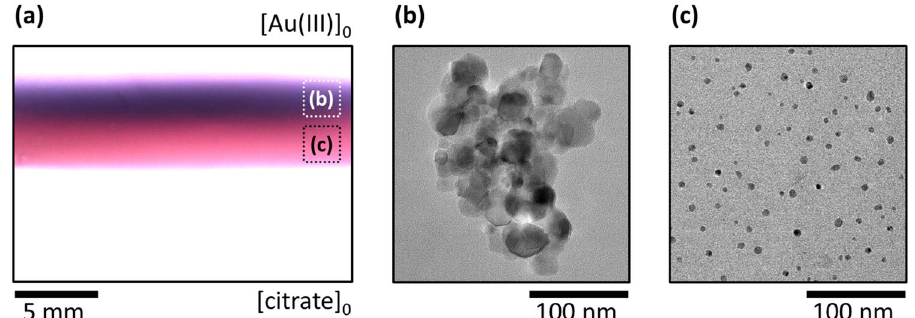
Figure 6. Synthesis of AuNPs in the two-channel gel reactor in the PAA gel. Top view of the inter-channel zone at the end of the experiment ( t = 24 h) ( a ) and representative TEM micrographs of the particles isolated from the purple ( b ) and red ( c ) regions. The labels [Au(III)] 0 and [citrate] 0 indicate the positions of the channels. The applied boundary concentrations were [Au(III)] 0 = 1 mM and [citrate] 0 = 10 mM,